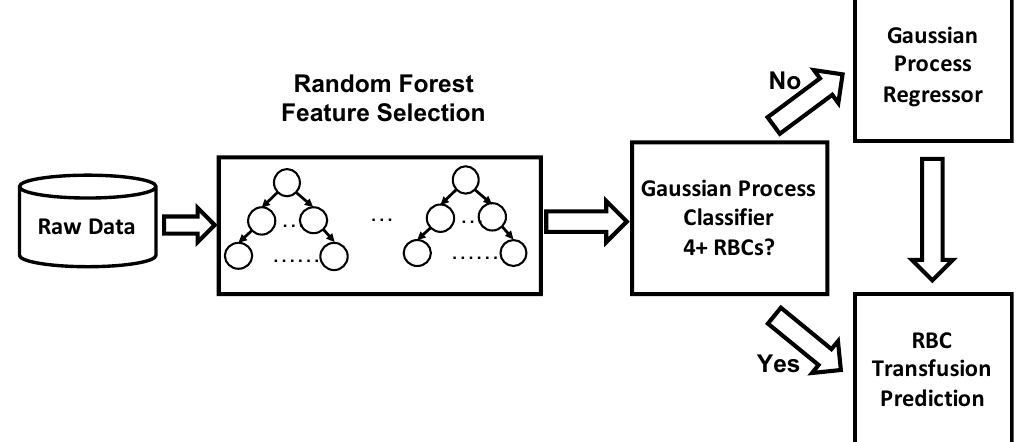
Figure 1. Feature selection and hybrid machine learning (ML) model. The raw cardiothoracic (CT) surgery dataset contained numerous features. To reduce the features to a manageable number, a random forest